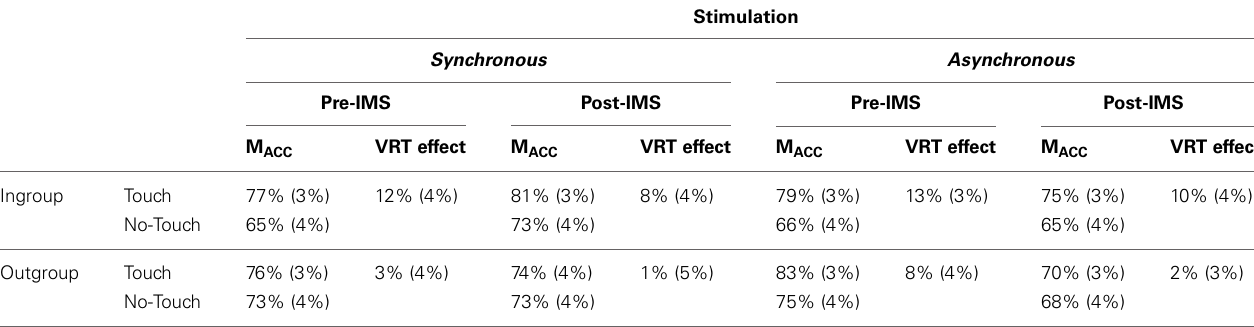
Table 3 | Mean scores ( ± standard error of the means indicated in brackets in italic font) for each face (Ingroup and Outgroup), for each Fingers’ Trajectory (Touch and No-Touch), for each timing of the VRT task (pre- and post-IMS) and for each type of IMS (synchronous and asynchronous visuo-tactile stimulation between the face of the model and the face of the